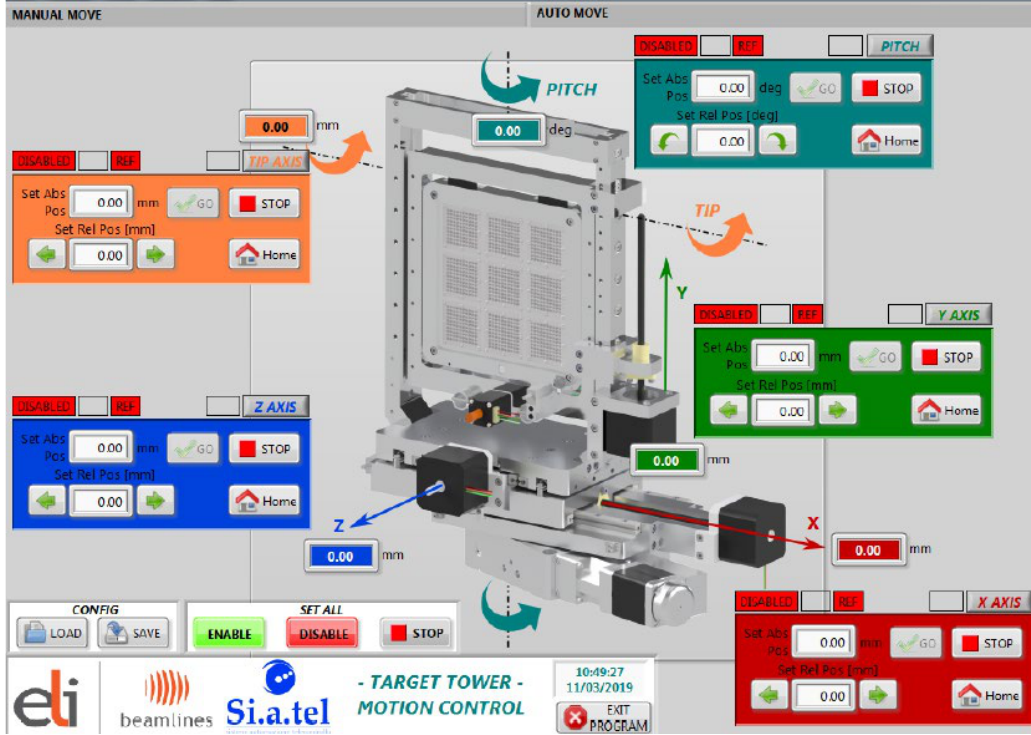
Figure 14. Target tower motion system main user interface .